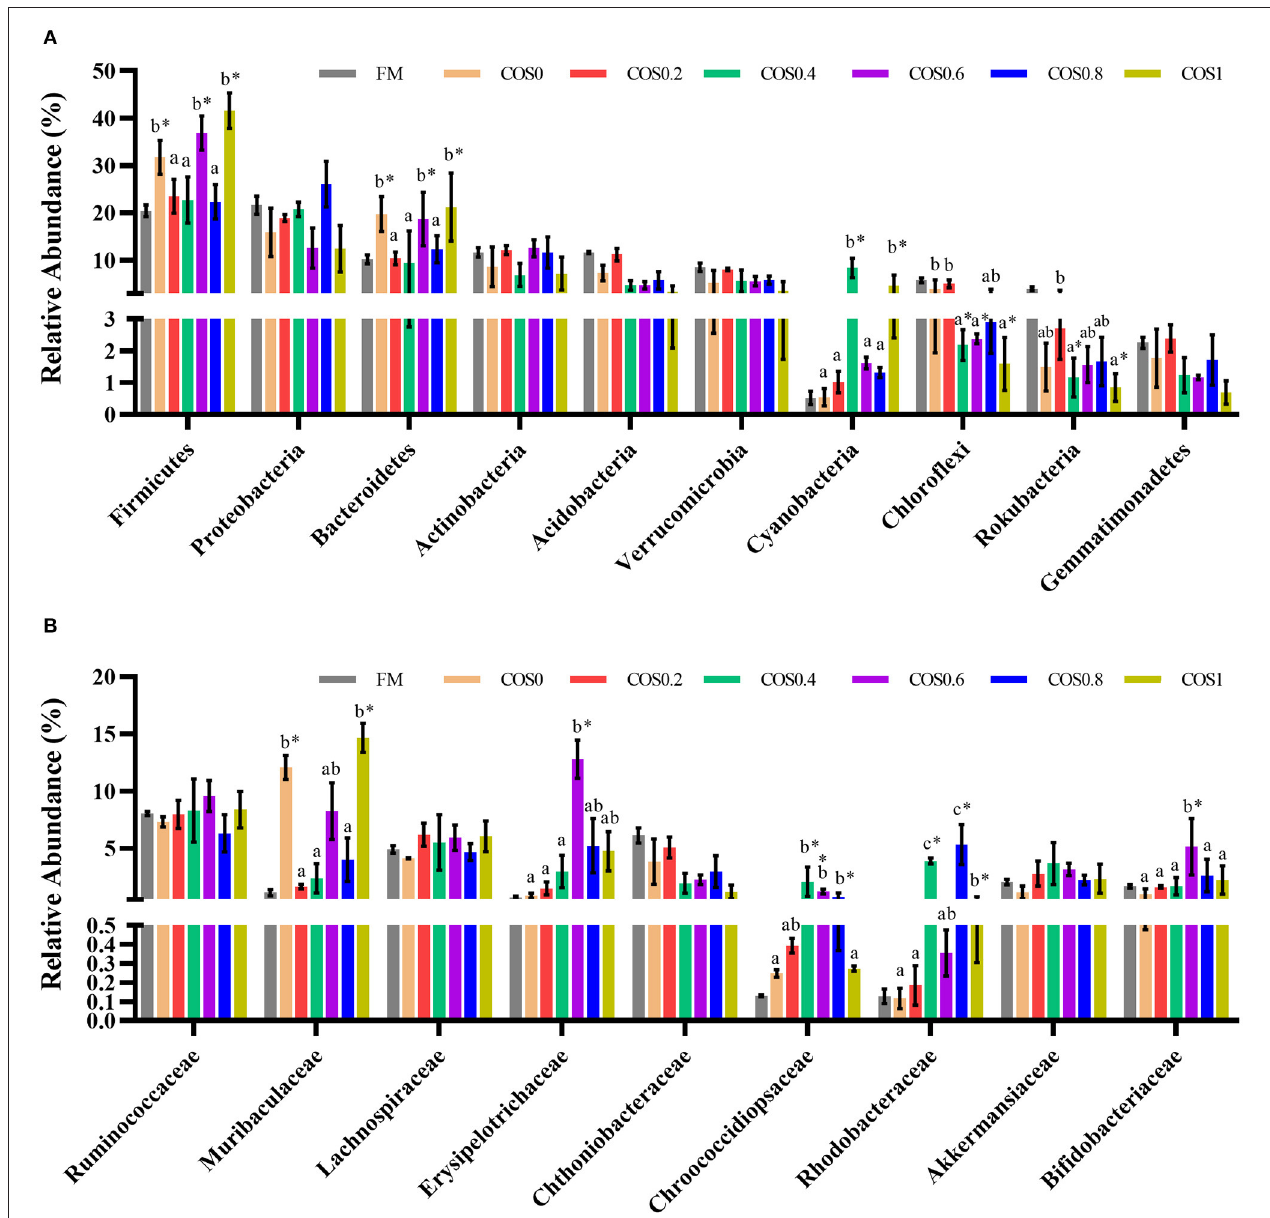
FIGURE 7 | (A) Relative abundance of major bacterial phylum in grouper intestinal microbiota. (B) Relative abundance of major bacterial family in grouper intestinal microbiota. Values are means ± SEM ( n = 3). Values in the same row with different superscript letters mean significantly different among COS-containing groups ( P